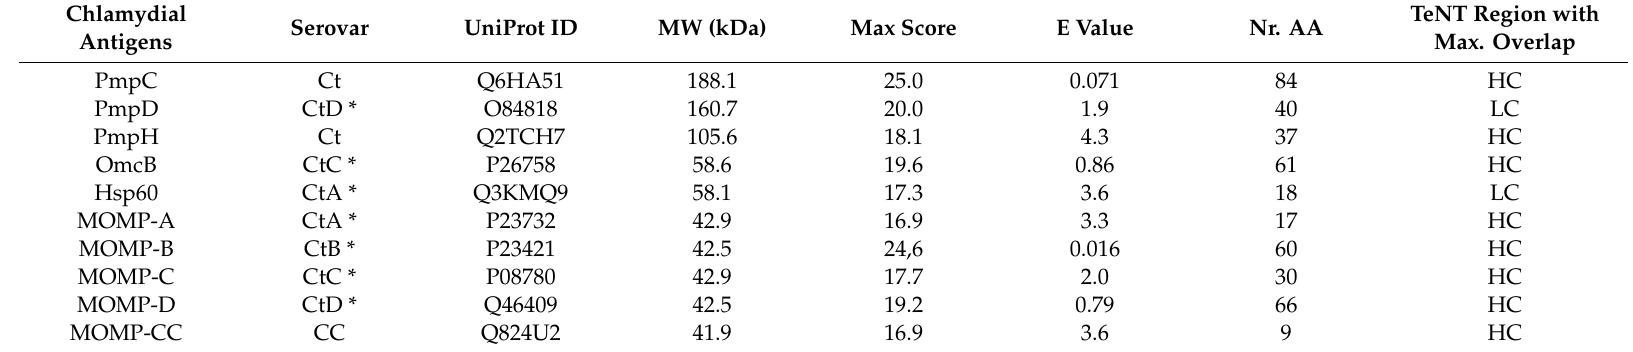
Table 1. Structural homology of short peptide sequences of chlamydial proteins and TeNT (UniProt ID